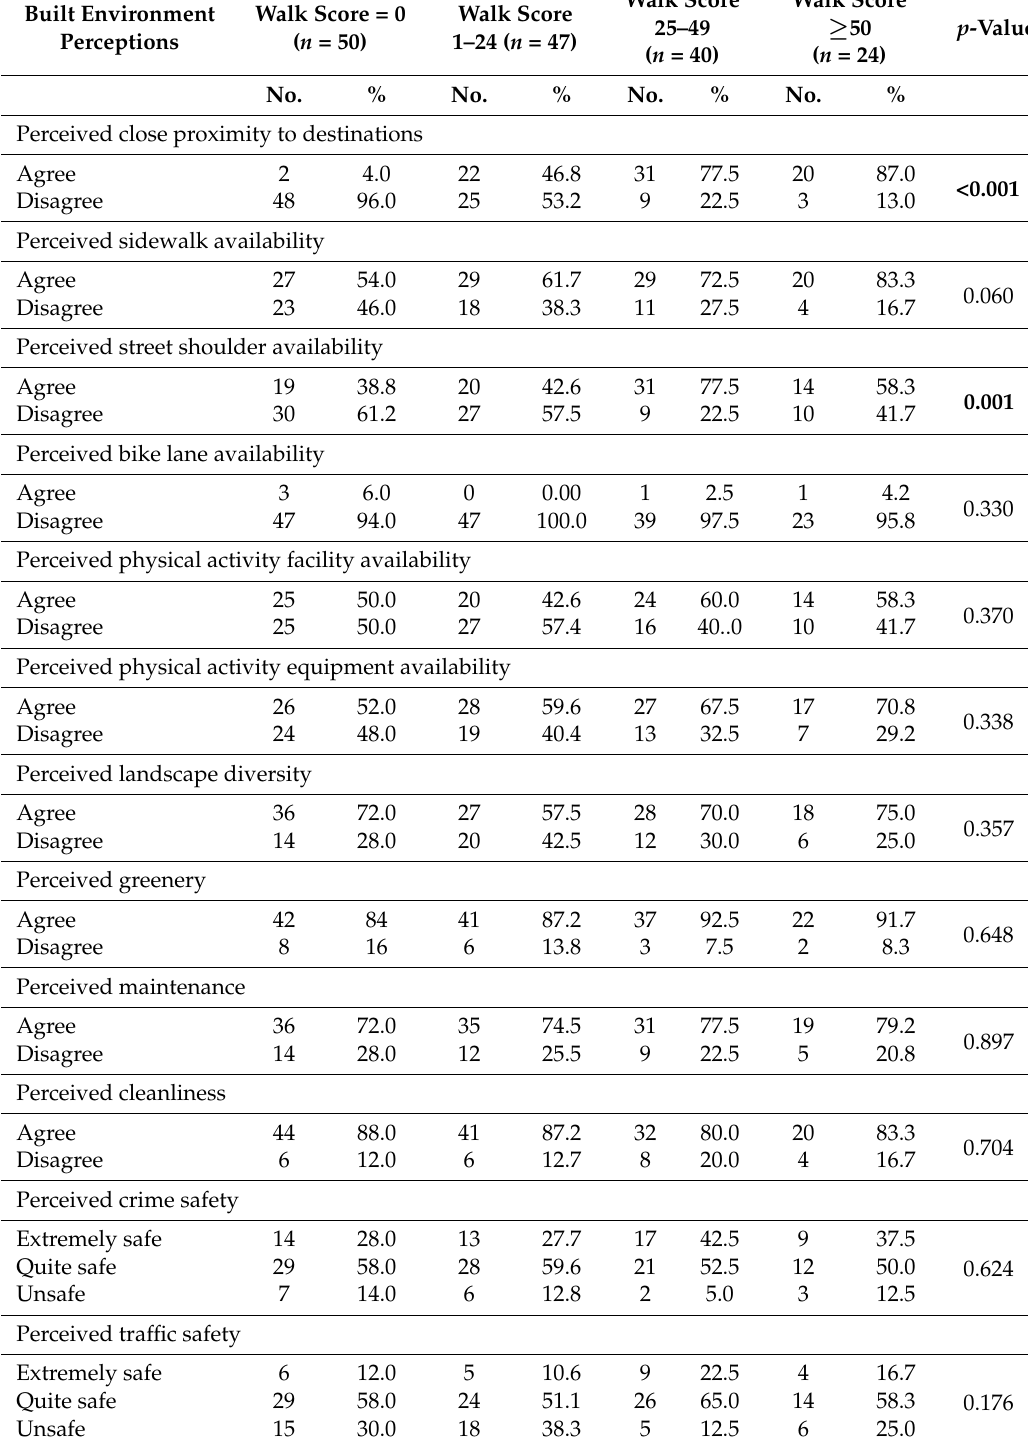
Table 2. Bivariate associations between Walk Score and perceived built environment characteristics among participants at